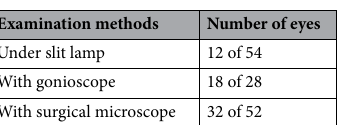
Table 2. Anterior chamber SO observation under various examinations. SO, silicone